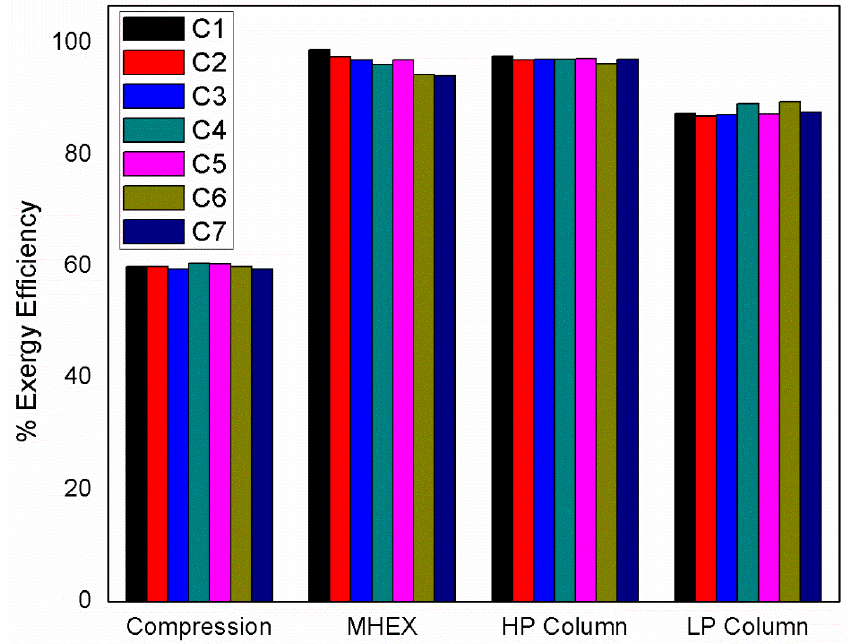
Figure 8. Section-wise exergy efficiency (%) for configurations C1 – C7.